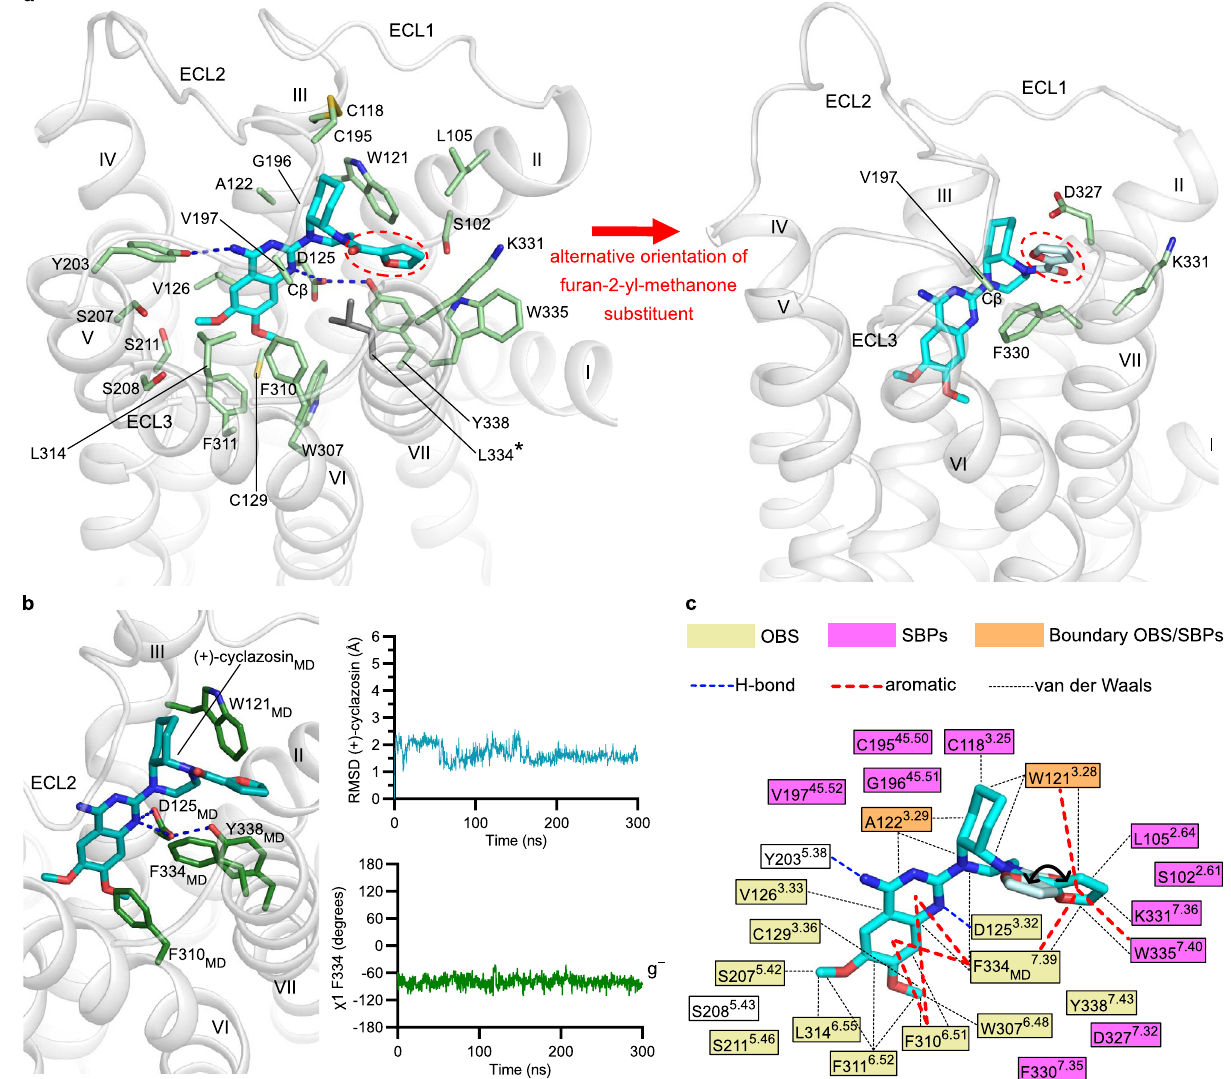
Fig. 2 ( + )-Cyclazosin binding pocket in α 1B AR XTAL . a Detailed view of the ( + )-cyclazosin binding site. ( + )-Cyclazosin is shown as sticks in cyan, with the two alternative orientations observed for the furan-2-yl-methanone substituent (highlighted by a dashed red ellipse) colored in cyan (on the left) and pale cyan (on the right), respectively. Receptor residues are shown as sticks in pale green except for the F334 → L mutation, which is colored in dark gray and is indicated by an asterisk. V197 is shown to C β only because its side chain is not resolved in the electron density map. Hydrogen bonds are depicted as dashed blue lines. Oxygen, nitrogen, and sulfur atoms are depicted in red, blue, and yellow, respectively. b MD simulation of α 1B AR XTAL-MD -V333-F334. The plots on the right indicate the structural stability of ( + )-cyclazosin and F334 MD throughout the simulation. RMSD, root-mean-square deviation; g − , gauche minus conformation of the χ 1 dihedral angle. For ( + )-cyclazosin, RMSD values were calculated on all atoms. A representative snapshot of the fi nal nanosecond of the simulation is depicted on the left, viewed from the same perspective as in panel a. ( + )-Cyclazosin is colored in teal; F334 MD is colored in dark green. c Schematic representation of the ( + )-cyclazosin binding site. OBS, orthosteric binding site; SBPs, secondary binding pockets. A black curved arrow indicates the two orientations observed for the furan-2-yl-methanone moiety. Note that residues C195 45.50 , G196 45.51 , and V197 45.52 belong to ECL2, which forms crystal contacts. Source data are provided as a Source Data fi le. signi fi cance (Supplementary Table 7). The remarkable impact of af fi nity observed for α 1B AR- α 2C (YLLY) corresponded to an A122 3.29 → L in α 1B AR is consistent with the observation that the ~5-fold improvement. No further improvement in the af fi nity of reciprocal L128 3.29 → A chimeric substitution in α 2C AR decreases RS79948 was observed by introducing chimeric substitutions at the ability of RS79948 to antagonize agonist-induced signaling the remaining three non-conserved positions within the binding by 50-fold 26 . We also made an α 1B AR mutant bearing all site of α 1B AR, i.e., L105 2.64 → N, S208 5.43 → C, and D327 7.32 → G four chimeric substitutions, i.e., W121 3.28 → Y, A122 3.29 → L, (Supplementary Table 6). We also replaced the entire ECL2 in α α α V197 45.52 → L, and L314 6.55 → Y — termed α 1B AR- α 2C (YLLY). 1B AR- 2C (YLLY) with the corresponding 2C AR sequence The af fi nity of RS79948 for α 1B AR- α 2C (YLLY) was improved by (from I178 4.58 to F202 5.37 , i.e., including the tips of TM4 almost three orders of magnitude compared to wild-type α 1B AR and TM5), generating α 1B AR- α 2C (YLLY;ECL2). However, no (Fig. 4a), approaching the af fi nity for α 2C AR. Compared to the further improvement in RS79948 af fi nity was observed upon the A122 3.29 → L chimeric substitution alone, the additional gain of replacement of ECL2 (Supplementary Table 6). NATURE COMMUNICATIONS| (2022) 13:382